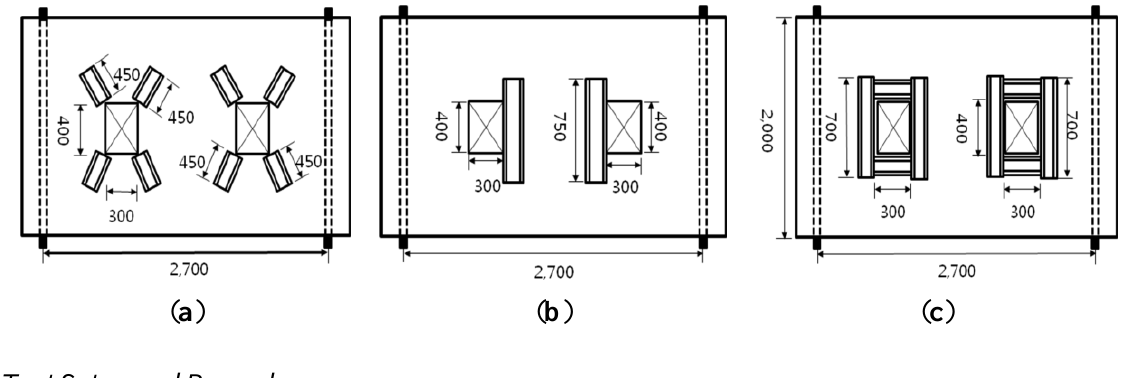
Figure 3. Strengthened configurations of ( a ) diagonal; ( b ) parallel; ( c ) surrounding slabs with openings.